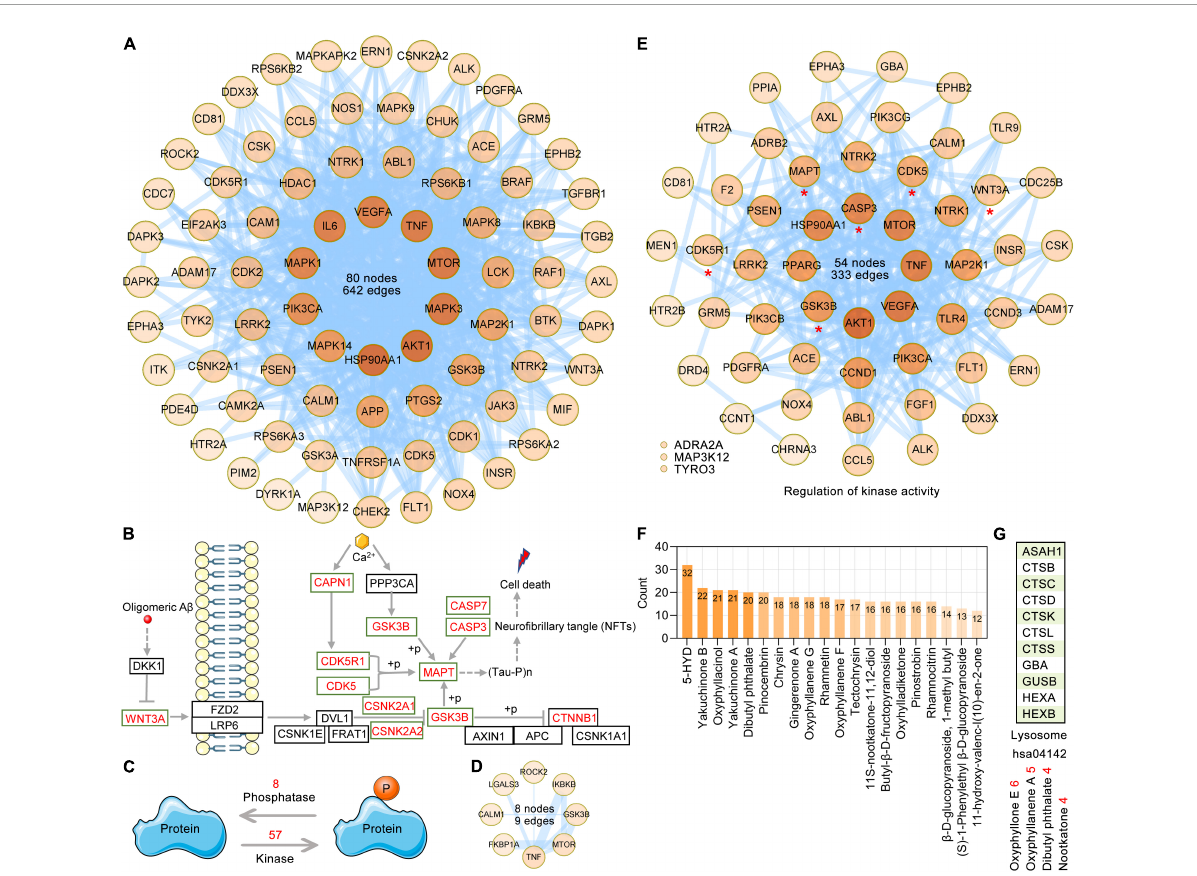
FIGURE6 Targeting AO targets associated with tau phosphorylation and degradation. (A) The PPI network was constructed for the 83 potential targets of AO associated with protein phosphorylation. Node color alludes to the degree value. (B) Schematic diagram of the regulatory mechanism of tau phosphorylation. The red font targets represent the AO targets involved in the regulation of tau phosphorylation. (C) The balance between protein kinase and phosphatase activities regulates the phosphorylation of protein. (D) PPI network of 8 AO targets involved in regulation of phosphatase activity (GO: 0010921). The thickness of the edges is correlated with the combined score. (E) PPI network construction for 57 AO targets involved in regulation of kinase activity (GO: 0033673 and GO: 0033674). (F) AO phytochemicals involved in tau phosphorylation ranked according to the numbers of targets. (G) AO phytochemicals corresponding to targets involved in lysosome pathway